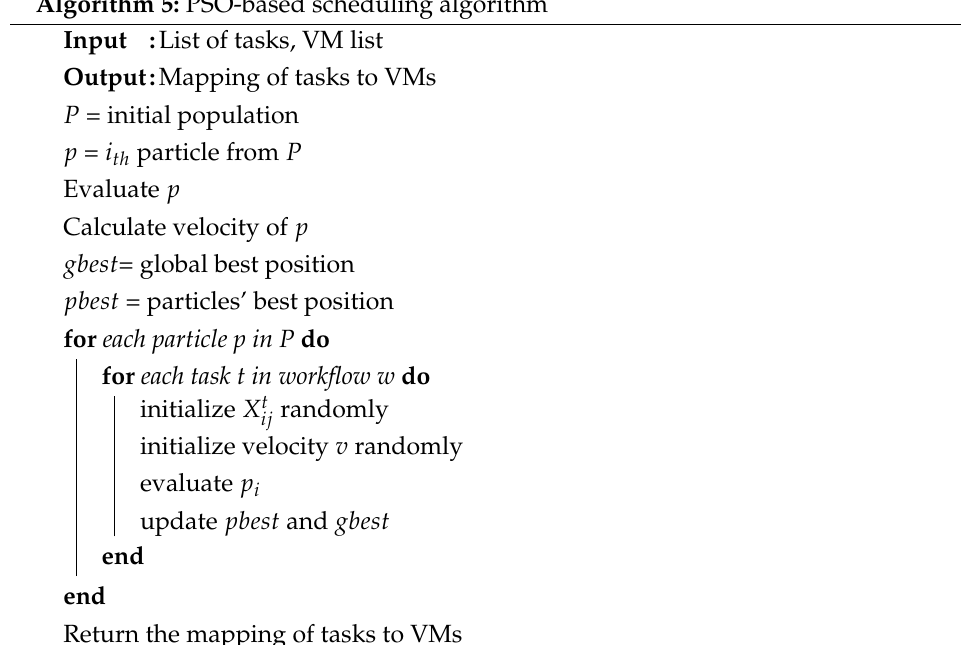
Algorithm 5: PSO-based scheduling